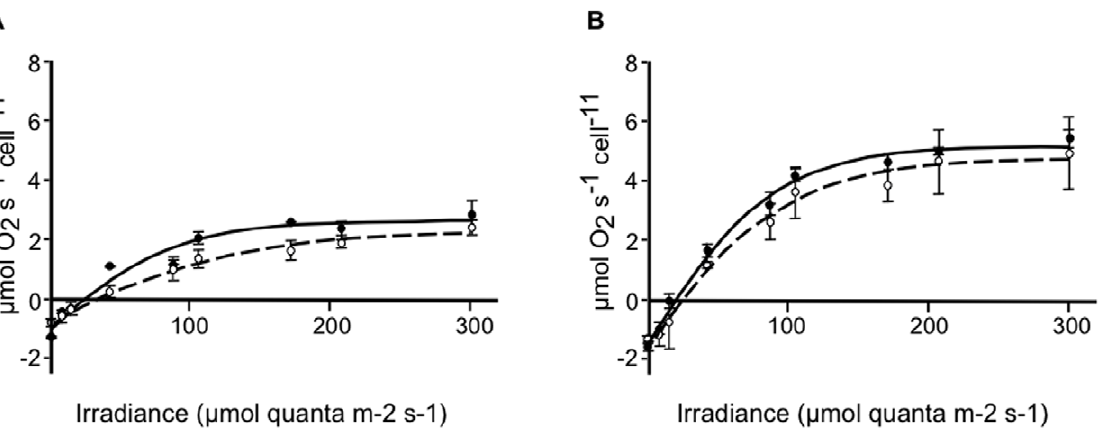
Figure 2. Photosynthesis vs irradiance (PE) curves normalized to cell density. Cells cultured for two weeks were incubated for 1 hr in control medium (solid line) or with the addition of 9% PEG (broken line). O 2 evolution was assessed under increasing light intensity, in Symbiodinium type B17 ( A ) and type A1 ( B ) cells. Each value represents the mean 6 SD (bars) from 3 independent experiments. Data were fitted to a hyperbolic tangent function.